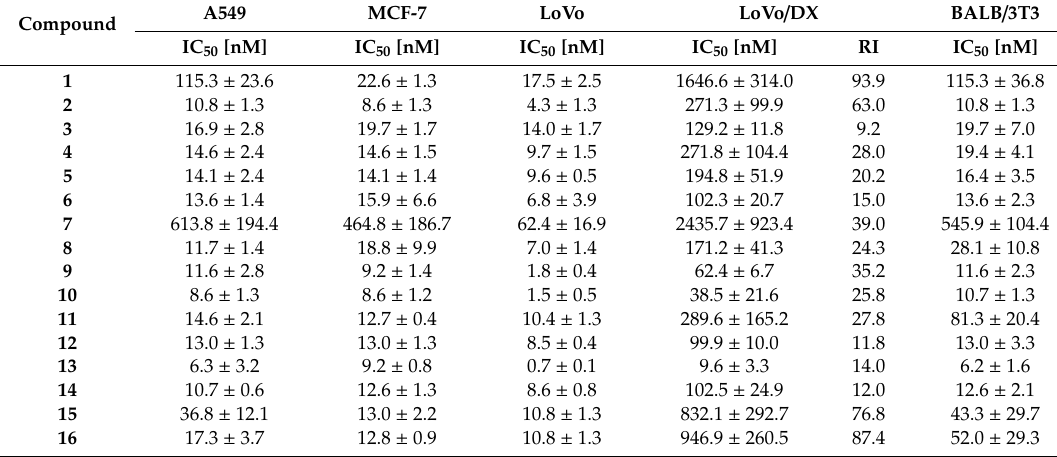
Table 2. Antiproliferative activity (IC 50 ) of colchicine ( 1 ) and its derivatives ( 2 – 21 ) compared with antiproliferative activity of standard anticancer drugs doxorubicin and cisplatin and the calculated values of the resistance index (RI) of tested